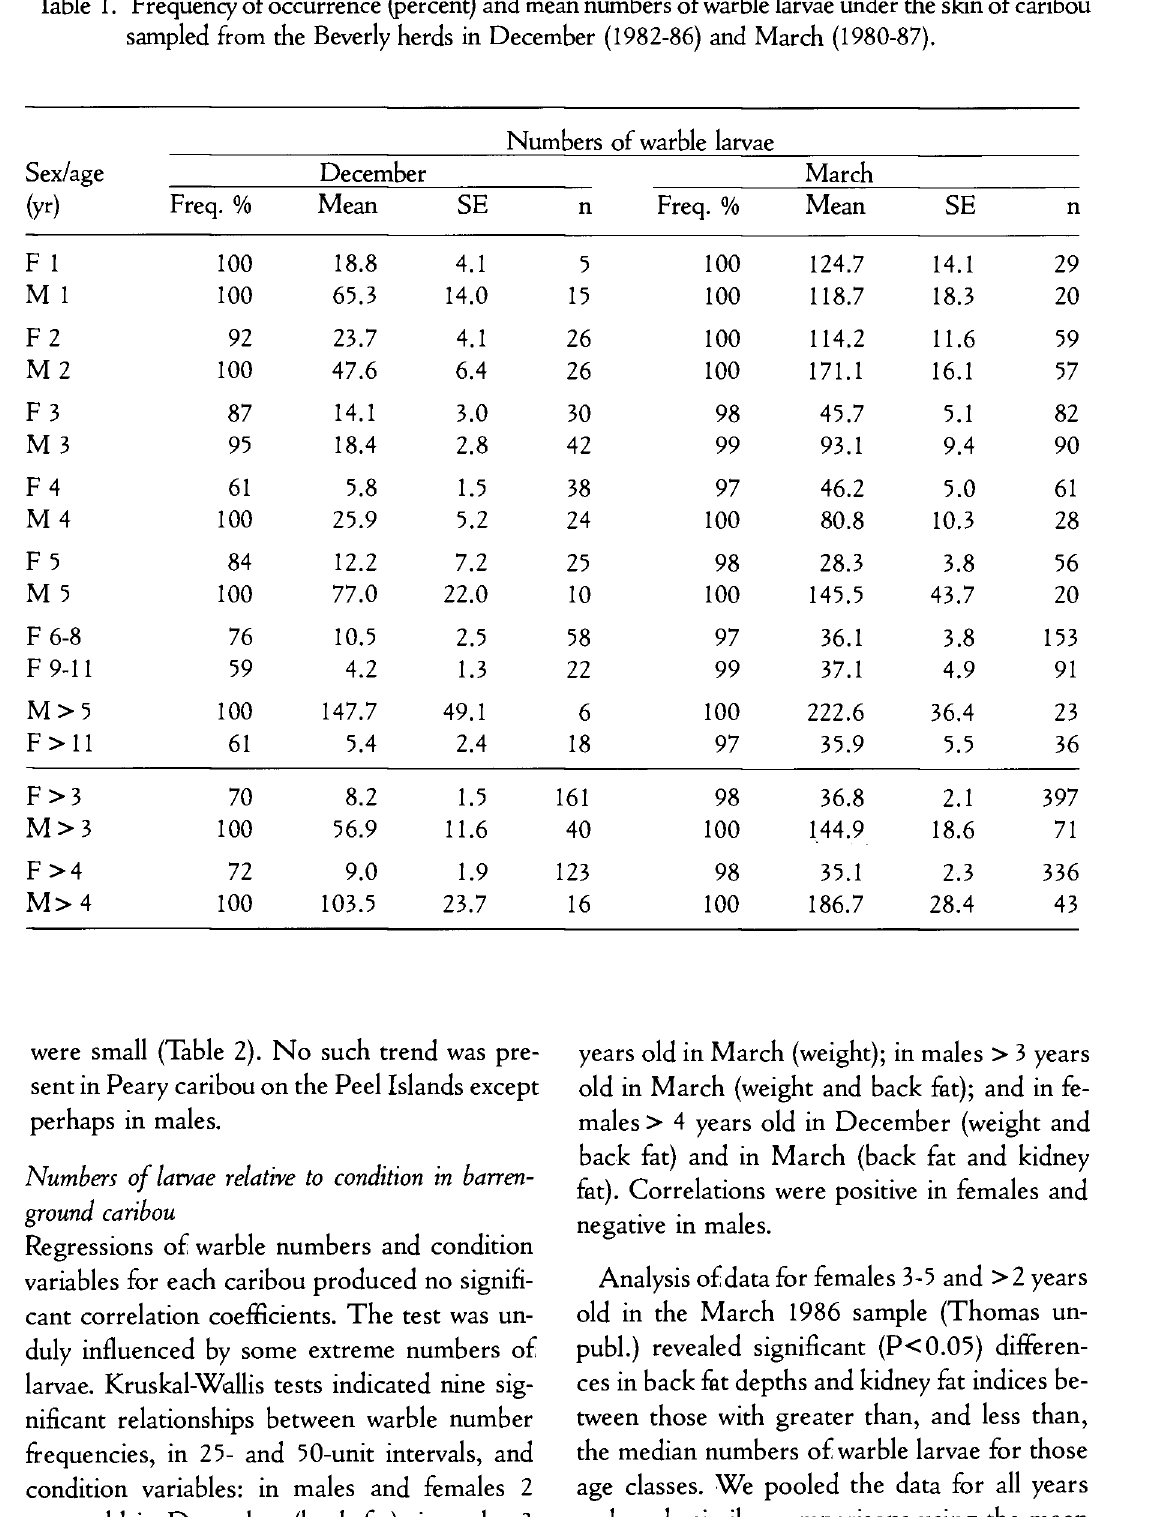
Table 1. Frequency of occurrence (percent) and mean numbers of warble larvae under the skin of caribou sampled from the Beverly herds in December (1982-86) and March